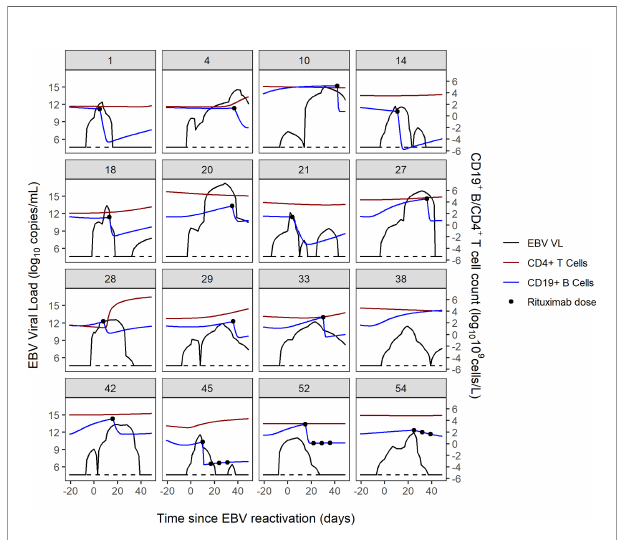
FIGURE 3 | Individual trajectories of EBV VL, CD19 + B cell and CD4 + T cell counts and rituximab dosing for 16 patients. Dotted black line represents the lower limit of detection of the EBV VL assay (200